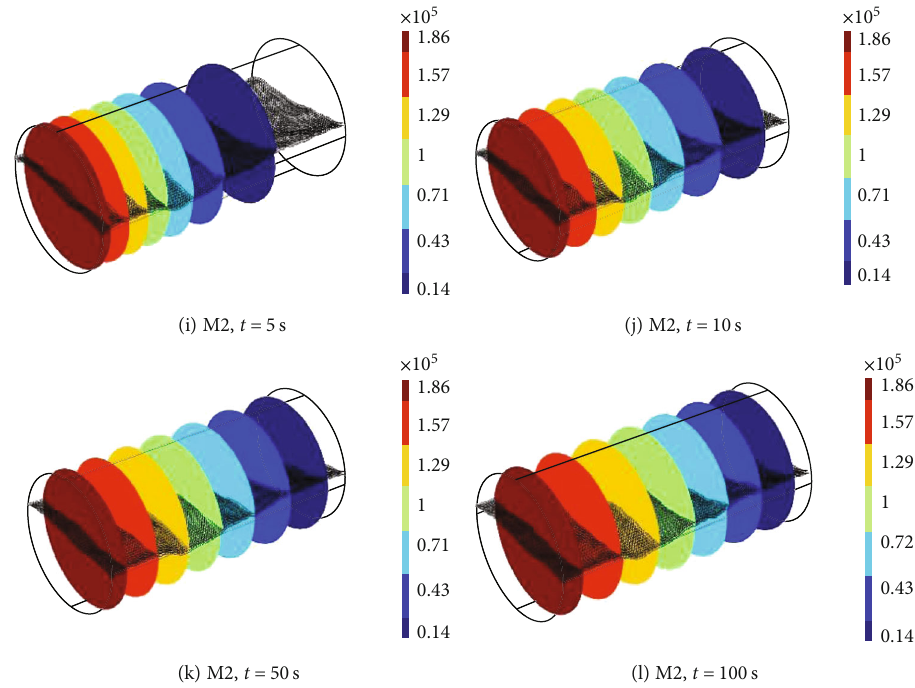
Figure 7: Variations in the isosurfaces of pore water pressure.